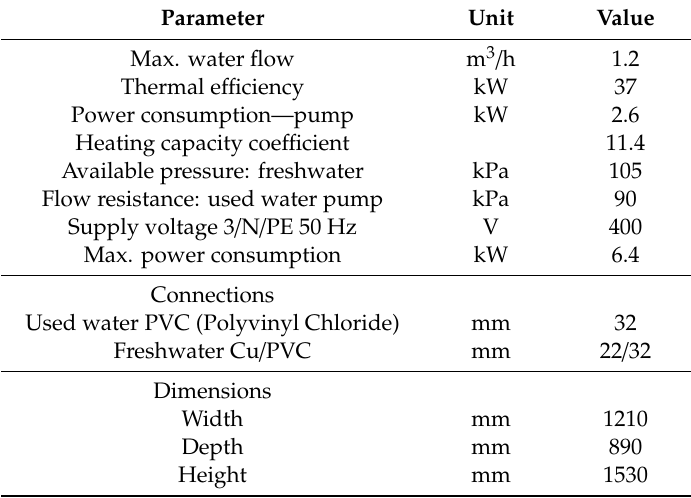
Table 3. Technical specification of wastewater heat recovery